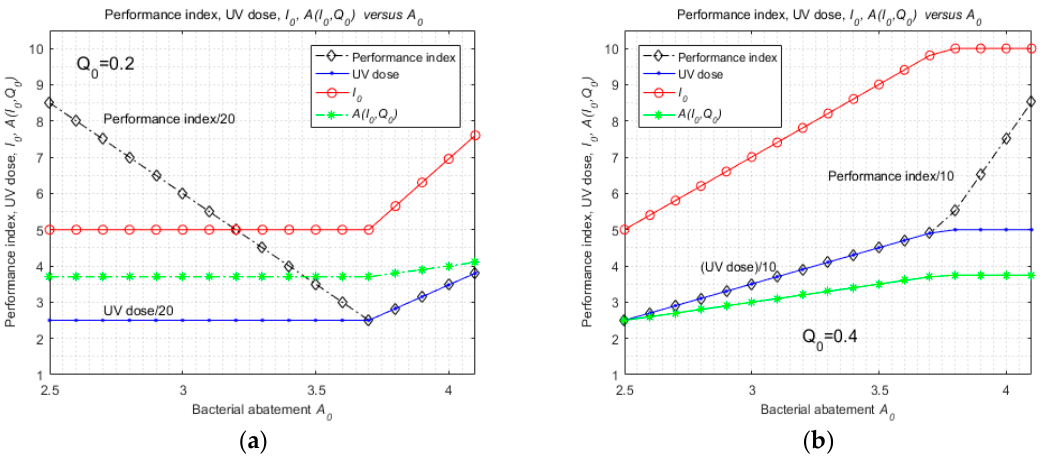
Figure 7. Optimal solutions with an imposed flow rate: ( a ) Q 0 = 0.2; ( b ) Q 0 = 0.4. Figure 7 depicts the placement of the optimal solutions in two individual